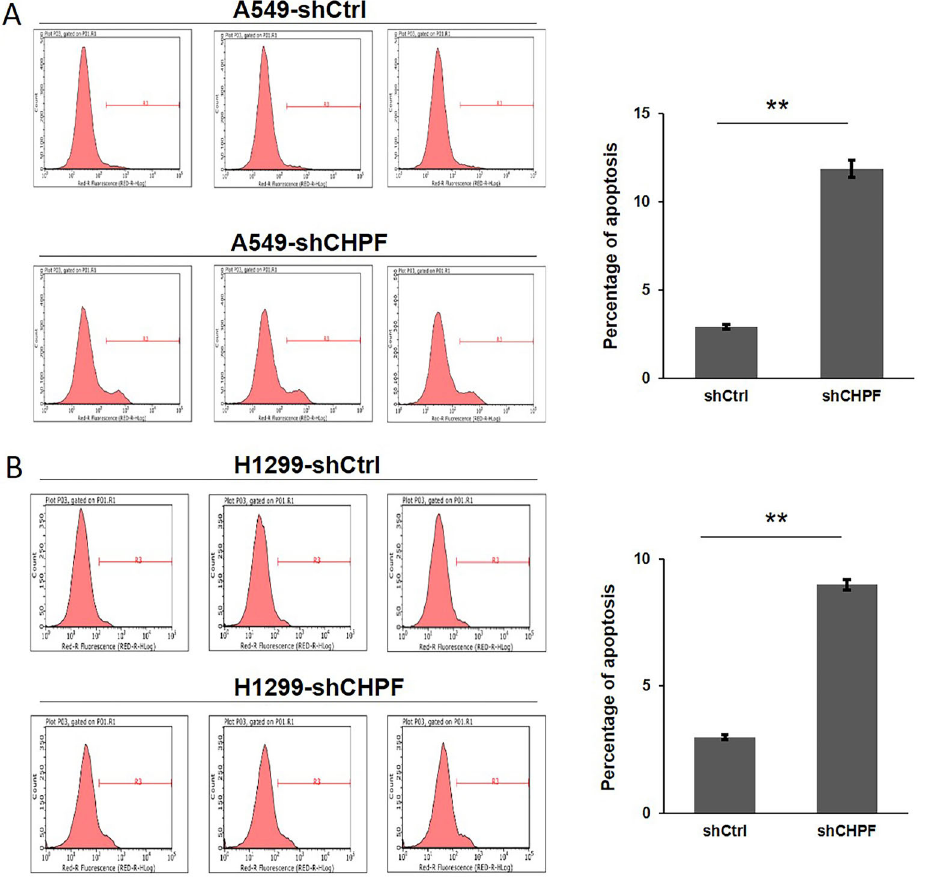
Figure 4. Effect of chondroitin polymerizing factor ( CHPF ) on the apoptosis of lung cancer cells. A and B , The apoptotic rates of A549 and H1299 cells after infection with shRNA- CHPF or shCtrl were analyzed by fl ow cytometry. Data are reported as means ± SD of three independent experiments. **P o 0.01 (Student ’ s t